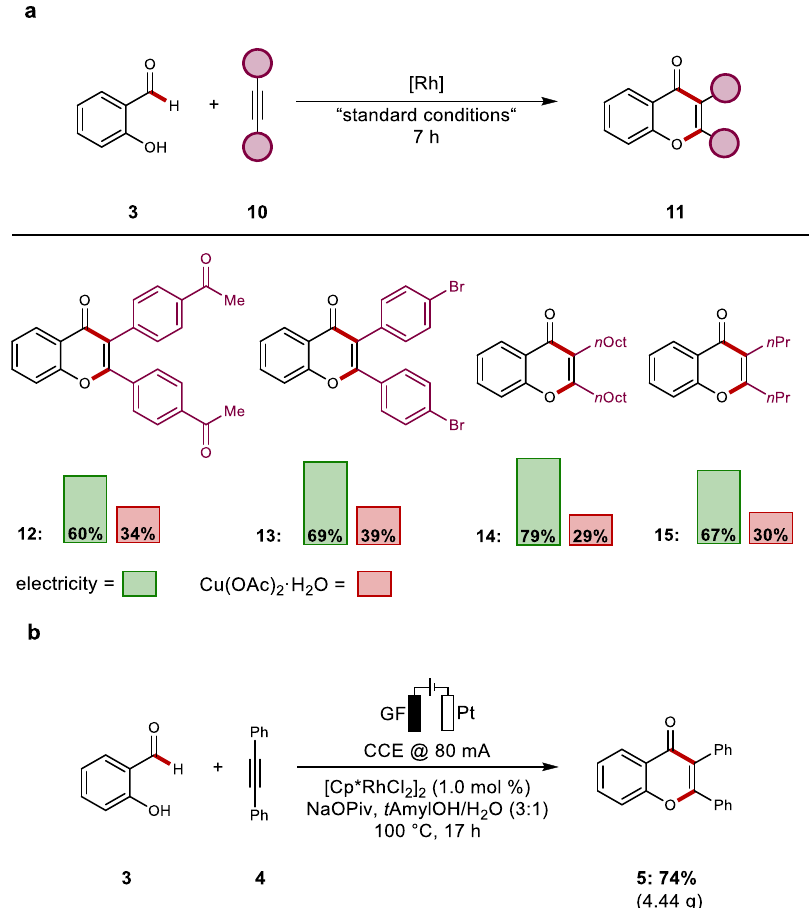
Fig. 3 Power of rhodaelectro-catalyzed annulation. a Comparison between rhodaelectro catalysis and Cu(OAc) 2 ·H 2 O as the chemical oxidant. b Rhodaelectro- catalyzed annulation on multigram